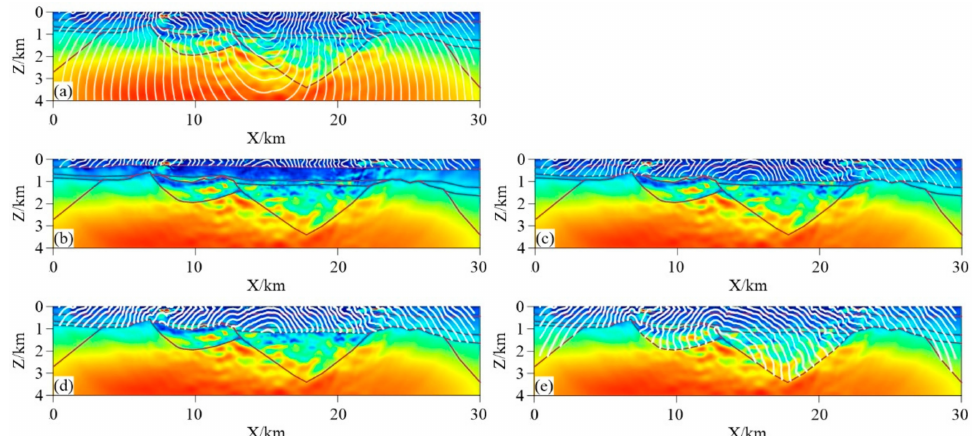
Figure 17. MFMM ray tracing of the Xiong’an model. The wavefront of ( a ) the first break, ( b ) the reflection wave of the bottom of Q, ( c ) the reflection wave of the bottom of Nm, ( d ) the reflection wave of the bottom of Ng, ( e ) the reflection wave of the top of Rongcheng High and Niutuozhen High.